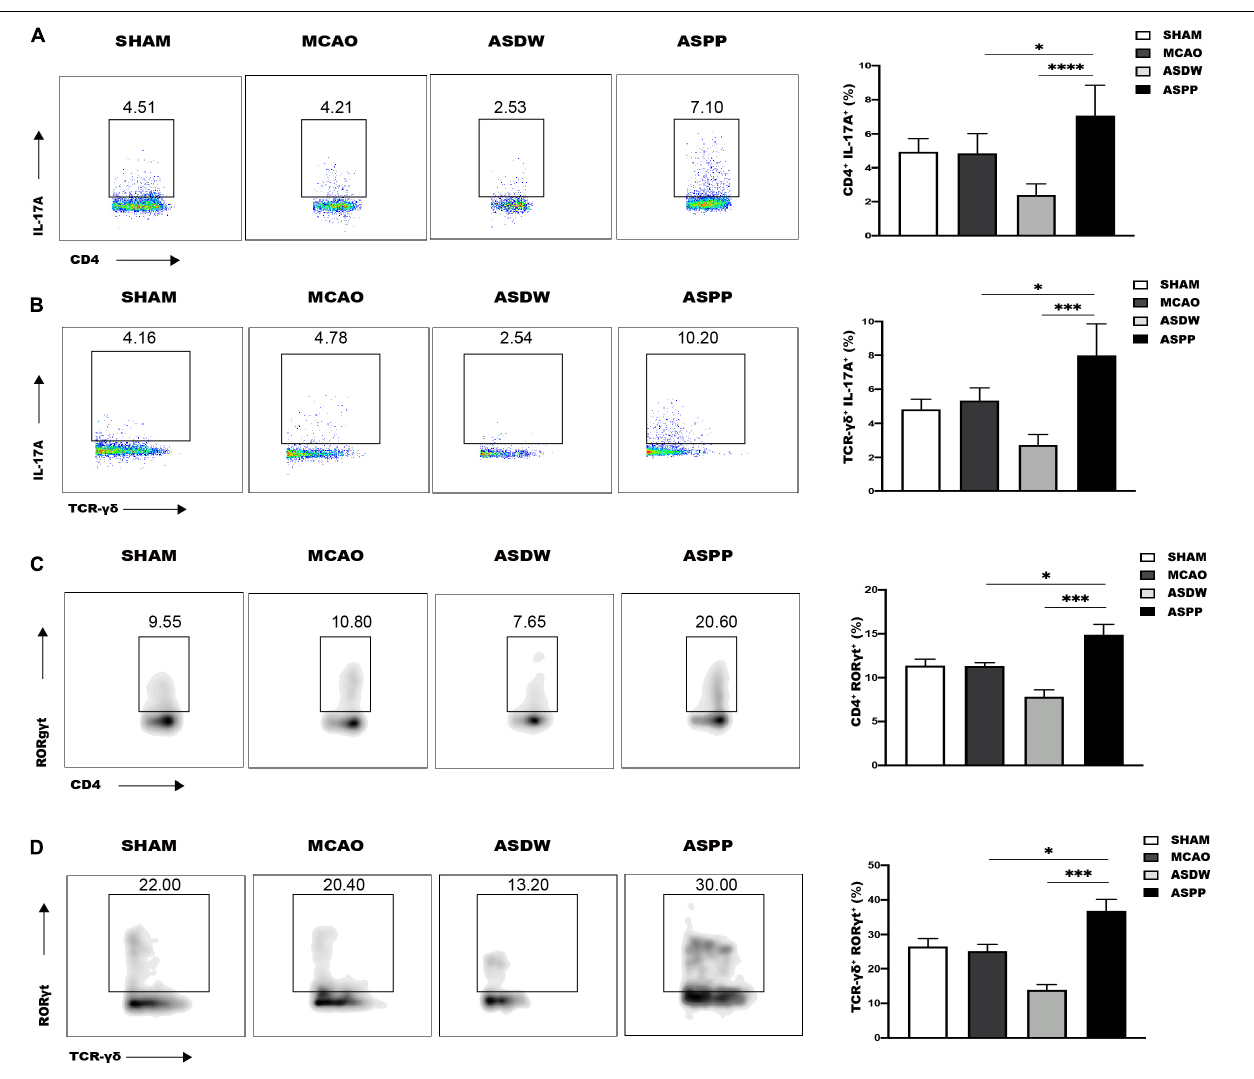
FIGURE 4 | Gavage of periodontitis salivary microbiota increases Th17 and IL-17 + γδ T cells in the small intestine. (A) Left, representative flow cytometry analysis of CD4 + IL-17A + cells (Th17 cells) in the small intestine. Right, quantification of Th17 cells. n = 5:5:6:6. (B) Left, representative flow cytometry analysis of TCR- γδ + IL-17A + cells (IL-17 + γδ T cells) in the small intestine. Right, quantification of IL-17 + γδ T cells. n = 5:5:5:5. (C) Left, representative flow cytometry analysis of CD4 + ROR γ t + T cells in the small intestine. Right, quantification of CD4 + ROR γ t + cells. n = 6:6:6:6. (D) Left, representative flow cytometry analysis of TCR- γδ + ROR γ t + cells in the small intestine. Right, quantification TCR- γδ + ROR γ t + cells. n = 5:5:5:5. Values represent mean ± SD . One-Way ANOVA was used for statistical analysis. ∗ p < 0.05, ∗∗∗ p < 0.001, ∗∗∗∗ p <